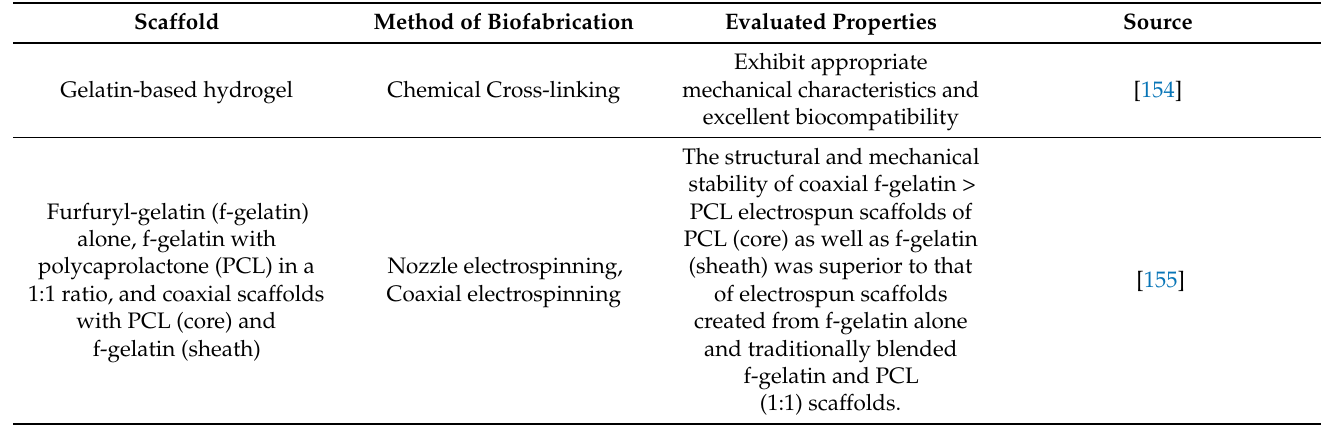
Table 2. Gelatin-based scaffolds for heart tissue engineering.